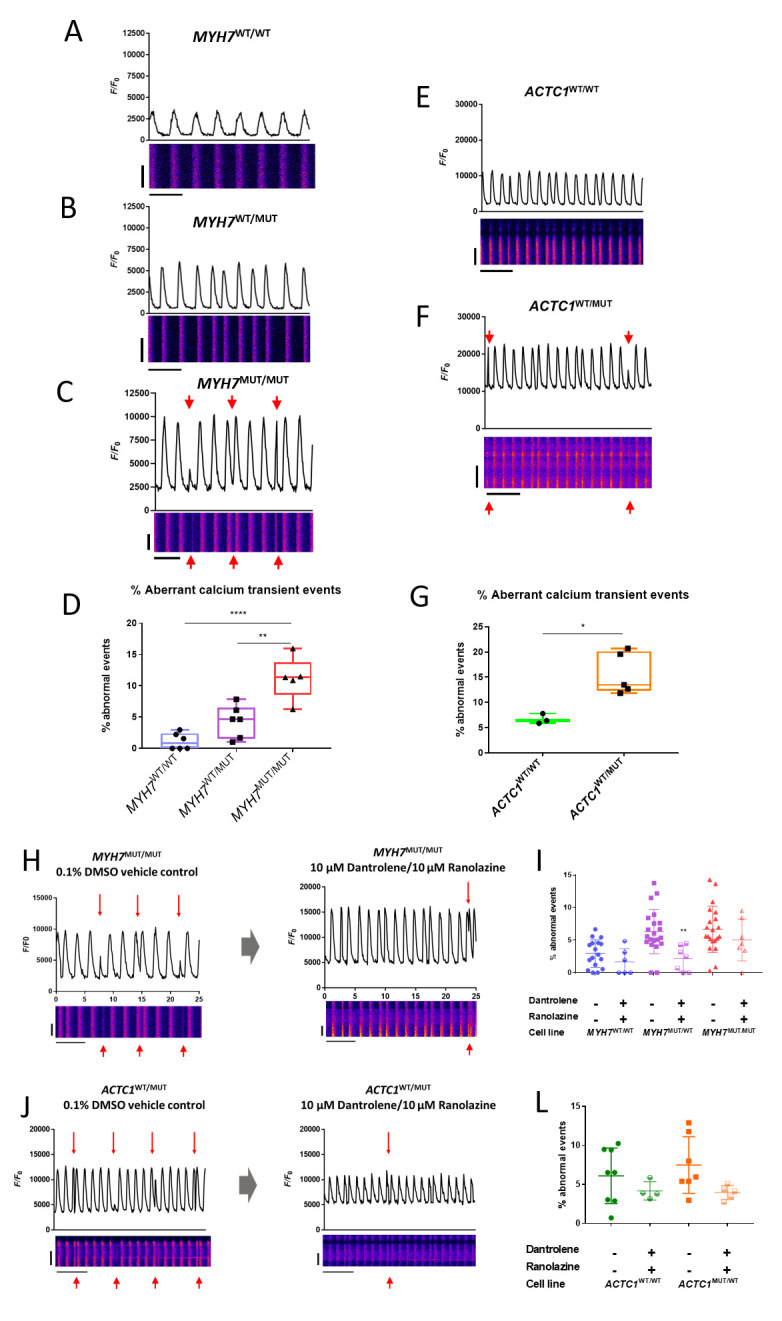
Functional application of
AAVS1-targeted R-GECO1.0 expressing clones for
in vitro disease modelling of HCM and phenotypic rescue with drug treatment.(
A–
C) Representative 25-second confocal laser line scan traces and kymographs for isogenic trio of c.
MYH7
C9123T R-GECO1.0 expressing hiPSC-CMs at day 30. Abnormal Ca
2+ transient events (red arrows) increase in frequency with mutation load. x-axis scale bar = 20 µm, y-axis scale bar = 5 seconds. (
D) Ca
2+ transient event detection and quantification showing percentage of Ca
2+ transients deemed abnormal. Data presented as mean ±SD, n = 6 scans across three differentiations. Kruskal-Wallis test with Dunn’s multiple comparison test; ** p = 0.0018, **** p < 0.0001. (
E–
F) Representative 25-second confocal laser line scan traces and kymographs for isogenic pair of c.
ACTC1
G301A R-GECO1.0 expressing hiPSC-CMs at day 30. Abnormal Ca
2+ transient events (red arrows) increase in frequency with mutation load. x-axis scale bar = 20 µm, y-axis scale bar = 5 seconds. (
G) Box-plot showing % of total Ca
2+ transient events detected deemed abnormal by event detection software. Data presented as mean ±SD, n = 5 scans from three differentiations. Unpaired t-test; * p = 0.0118. (
H–
L) Representative line scans and event detection quantification showing a reduction in abnormal Ca
2+ transient events upon treatment with 10 µM ranolazine and 10 µM dantrolene compared to 0.1% DMSO vehicle control. Data presented as mean ±SD, n > 4 cells across minimum of two differentiations. Kruskal-Wallis test with Dunn’s multiple comparison test; ** p = 0.0068. x-axis scale bar = 20 µm, y-axis scale bar = 5 seconds.